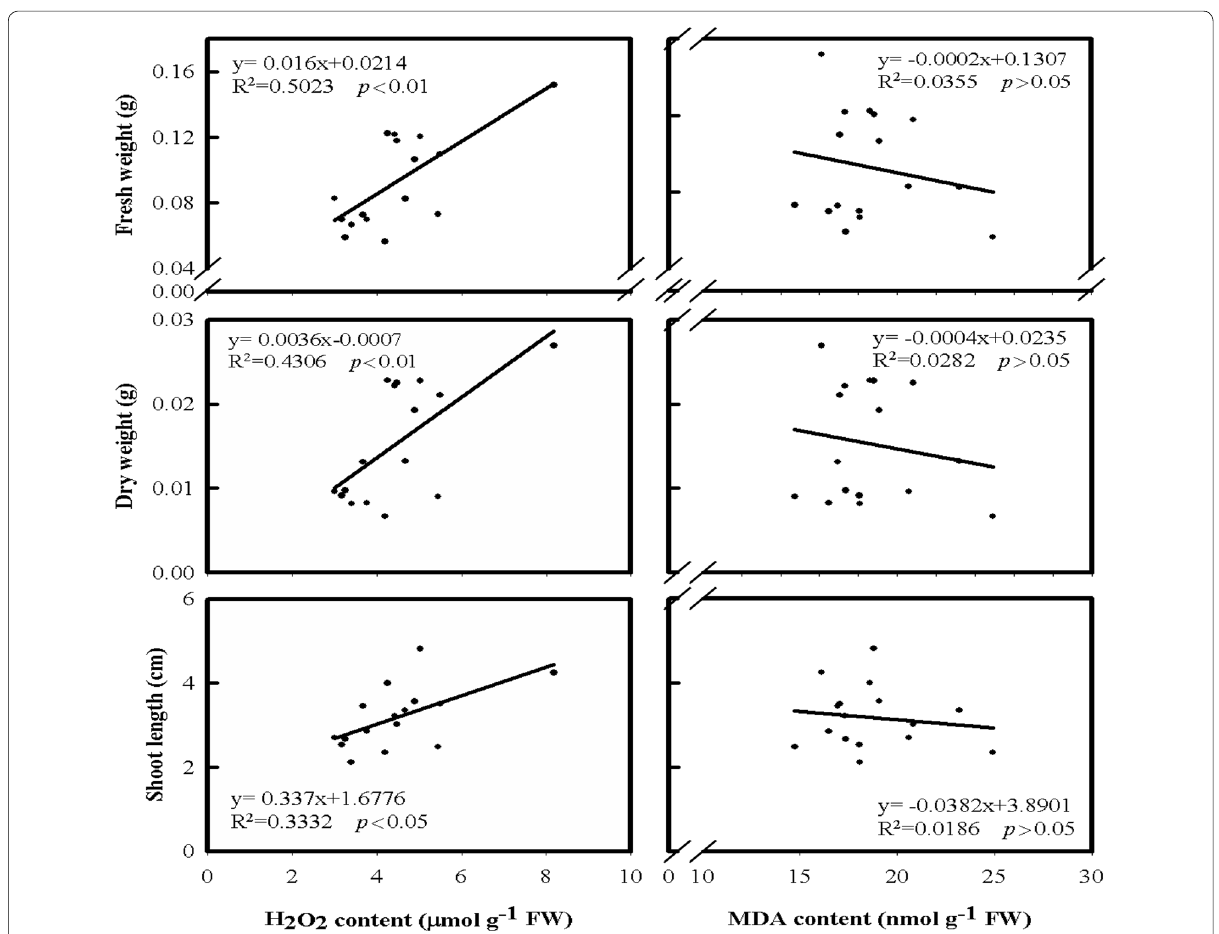
Fig. 3 The relationships of leaf H 2 O 2 and MDA contents with shoot fresh weight, dry weight and length under cold treatment among eight rice cultivates. The temperature was set at 15 °C for cold treatment and 27 °C for control. After 4 days of treatment, the temperature was adjusted to 27 °C for 3 days before